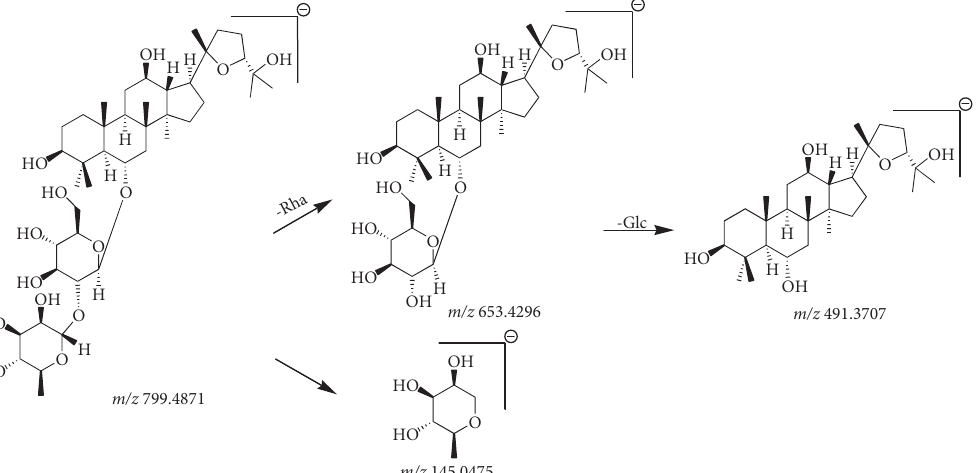
Figure 12: Secondary mass spectrogram of pseudoginsenoside F